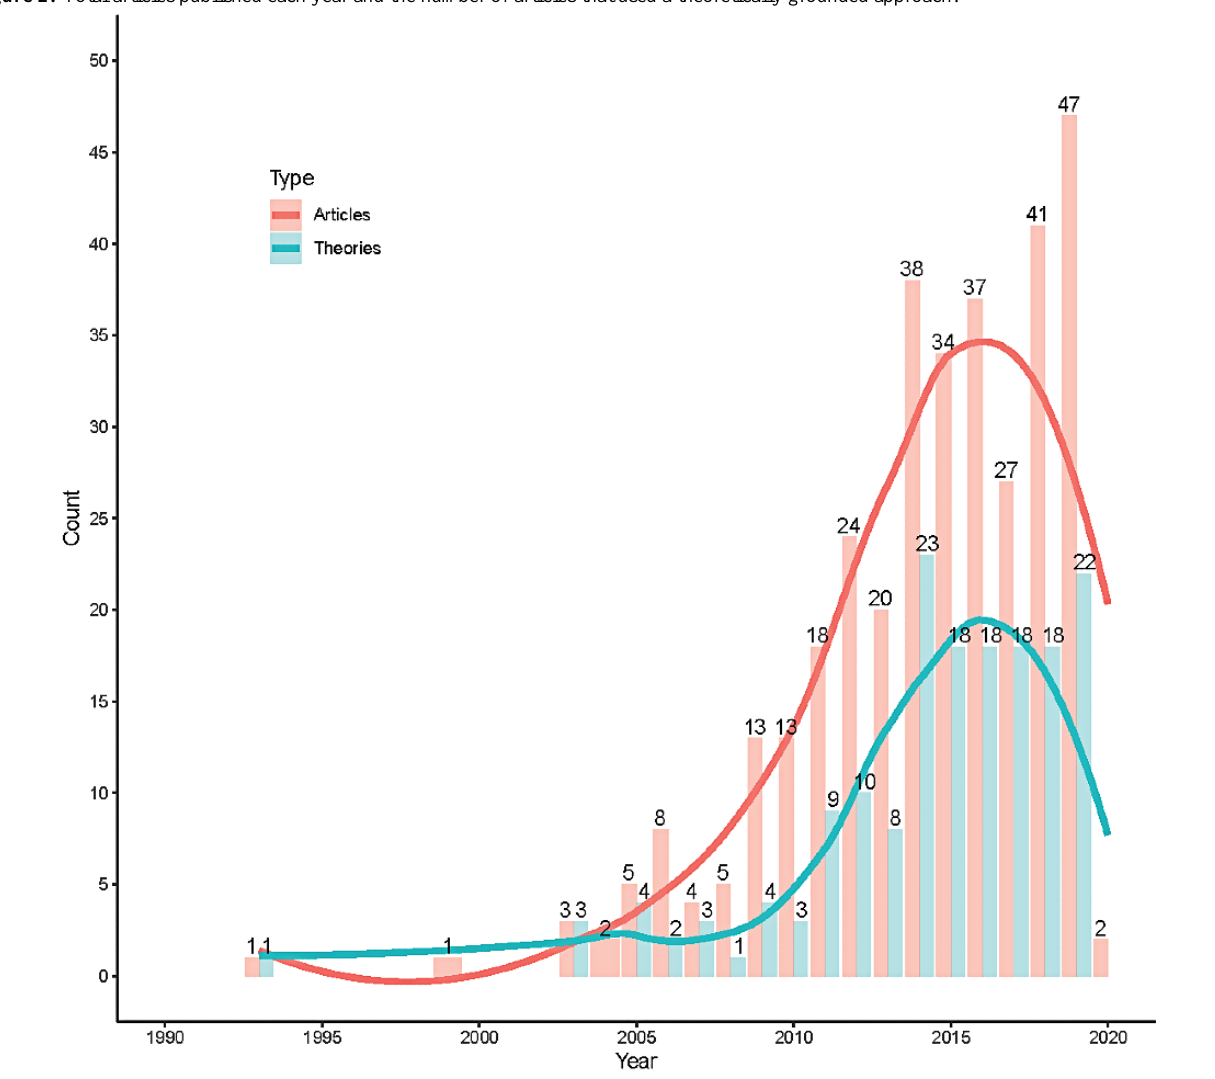
Figure 2. Total articles published each year and the number of articles that used a theoretically grounded